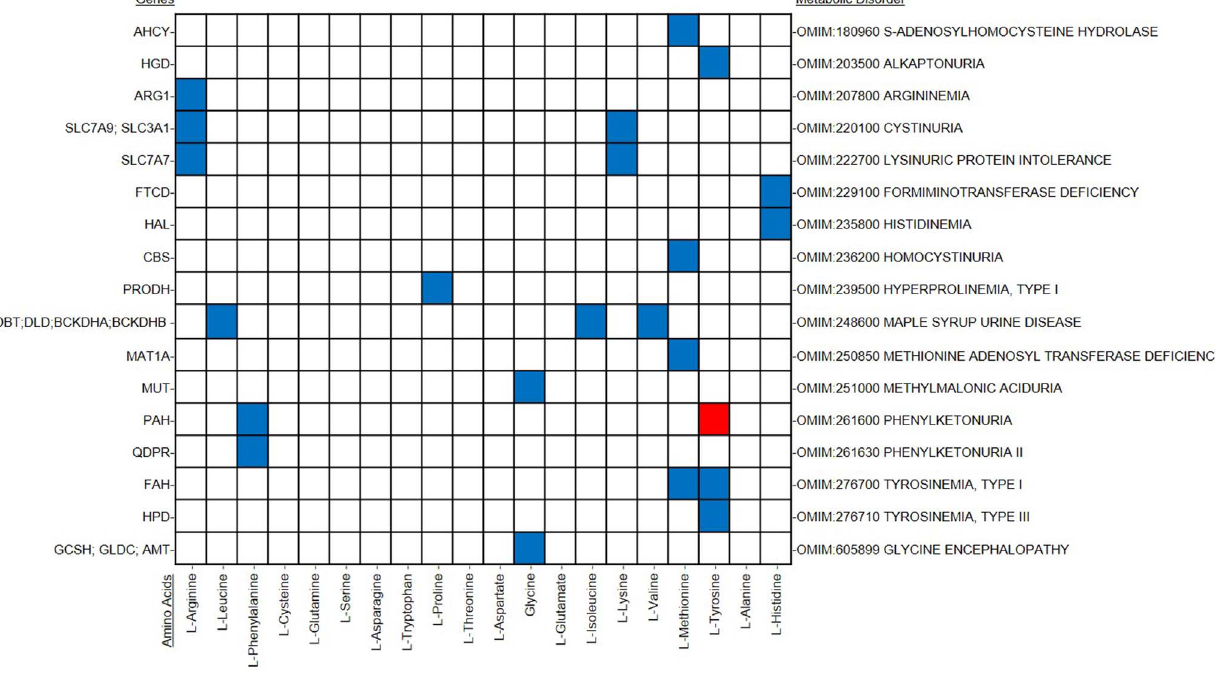
Figure 2. OMIM data used for model validation. Blue and red squares depict an increase and decrease in concentration, respectively. White squares represent unchanged concentration levels.